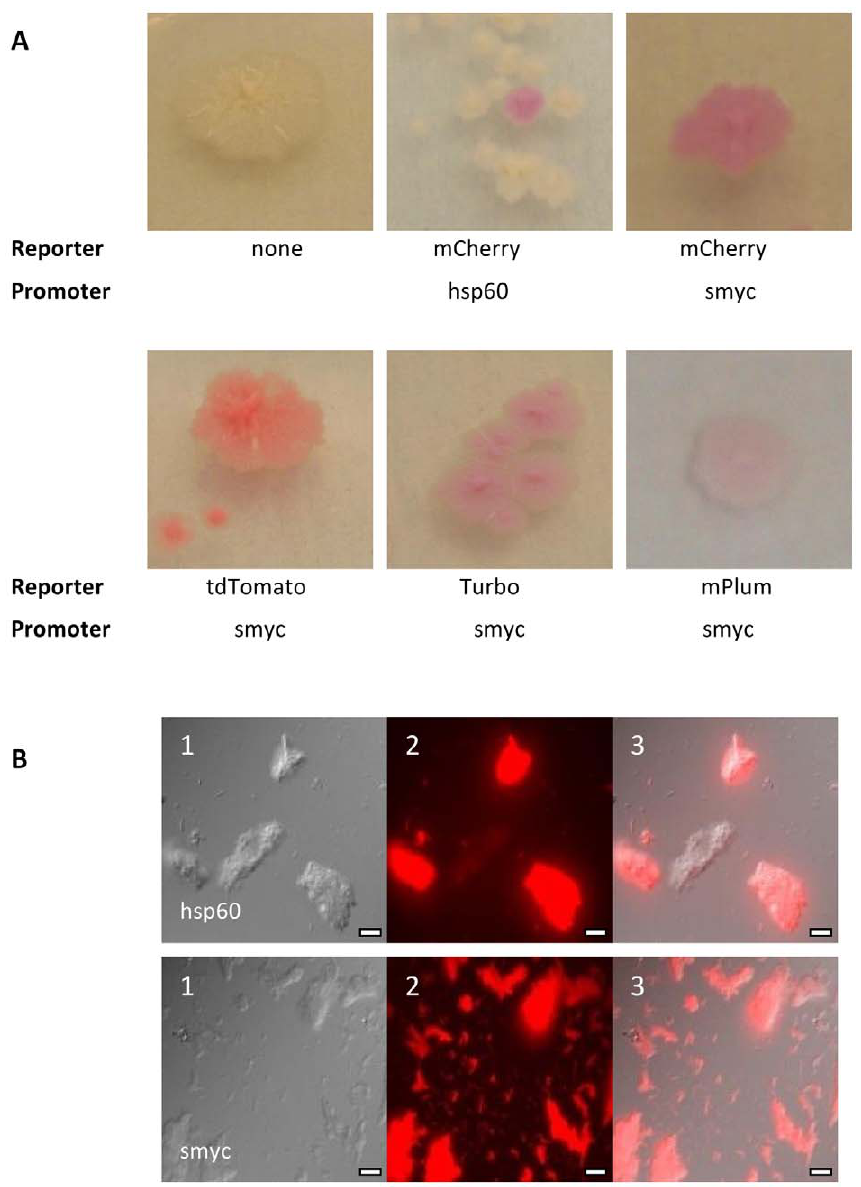
Figure 6. Detection of fluorescent reporter in M.tuberculosis H37Rv. FP expression plasmids were transformed into M. tuberculosis and colonies isolated on hygromycin-containing plates. (A) Expression of several fluorescent reporters gave rise to coloured colonies. (B) Microscopy of fluorescent mCherry reporter driven by either P hsp60 or P smyc . Scale bar is equal to 10 m m.